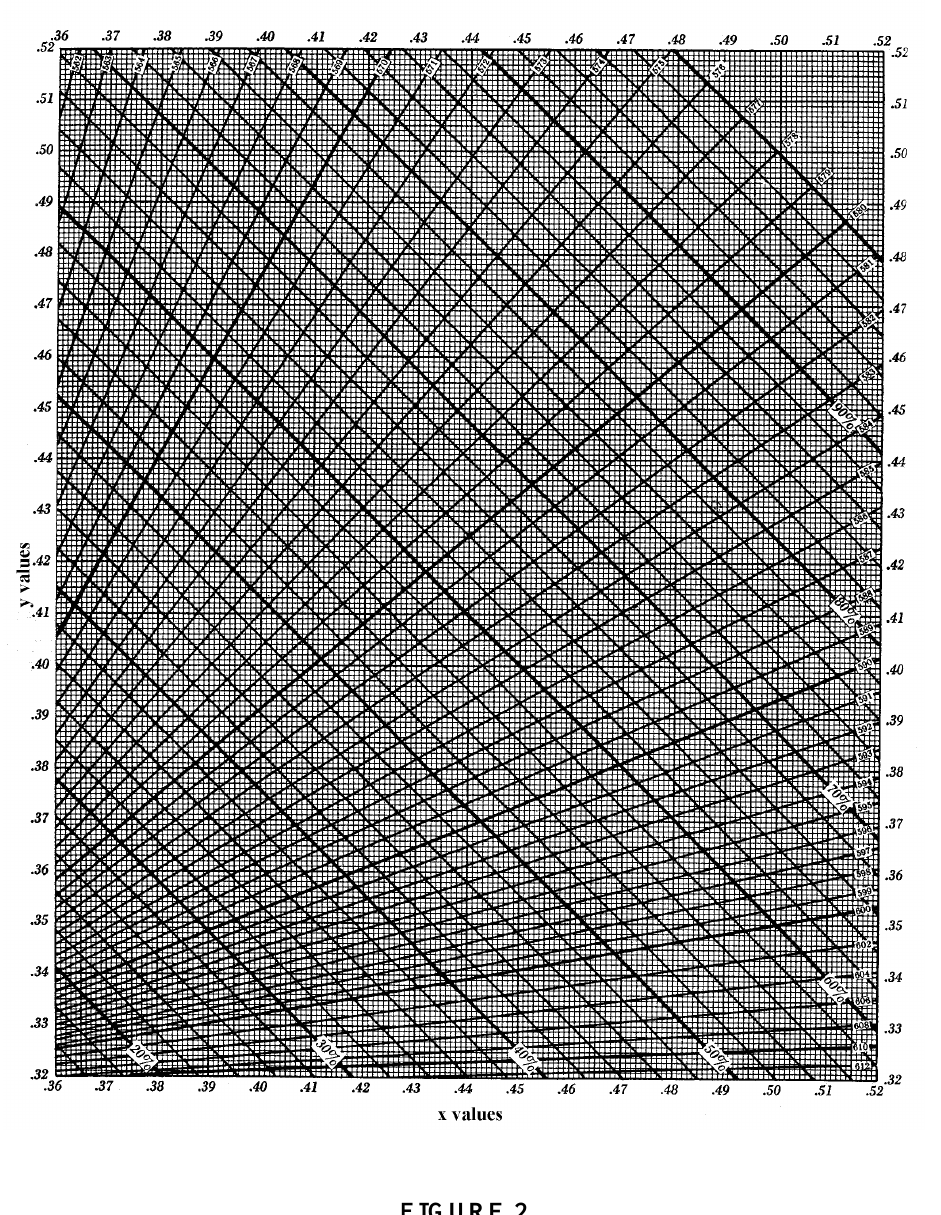
Chromaticity diagram for pure red wines and brick red